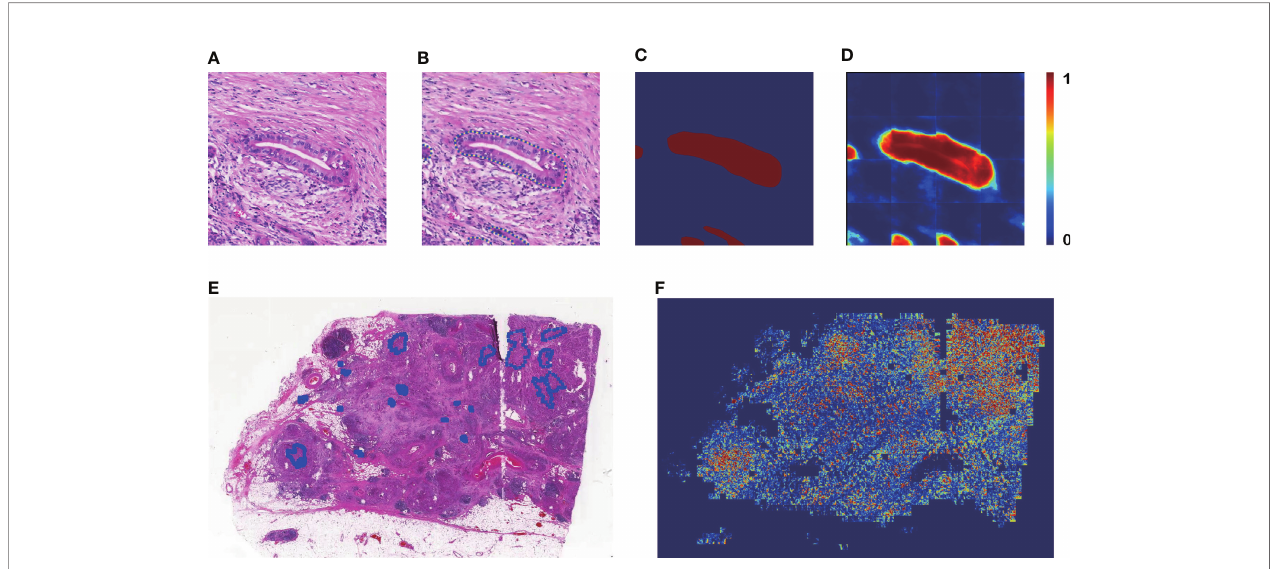
FIGURE 3 | Results of patch-level segmentation. (A) A sample raw patch. (B) Annotated patch. (C) Mask generated by the annotation. (D) Heatmap of the sample patch predicted by our method. (E) A sample WSI with annotation. (F) Heatmap of the sample WSI comprising the heatmaps predicted for each patch.